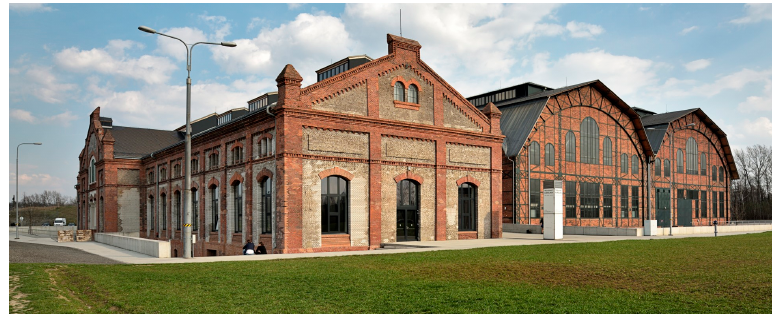
Figure 1. Part of the revitalized brownfield “Karolina”.